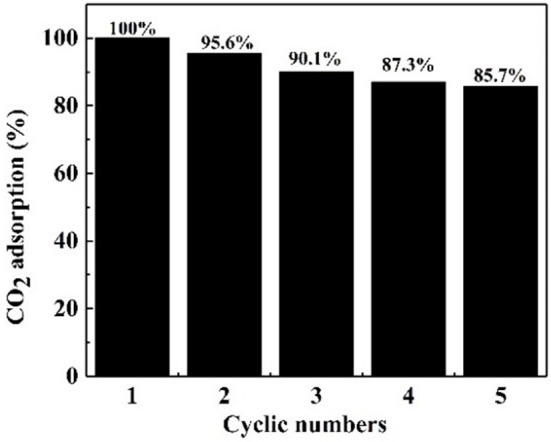
Cyclicity of NS–NR2 adsorbent in water.